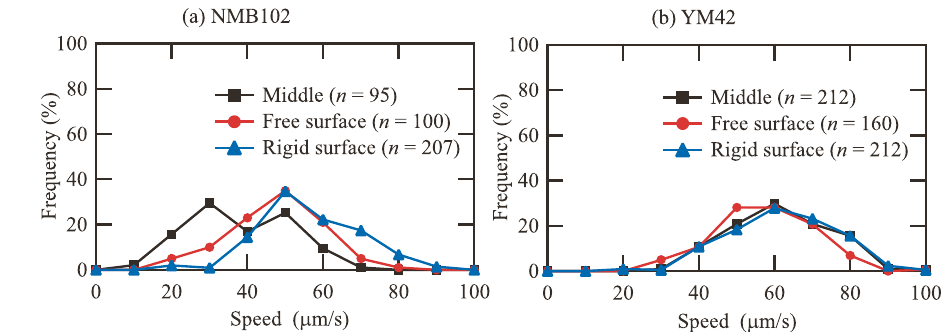
Fig. 3 Distributions of swimming speed of (a) NMB102 and (b) YM42 in the middle, near the free boundary and near the rigid boundary. The symbol n in the legend indicates the number of data points for each case.